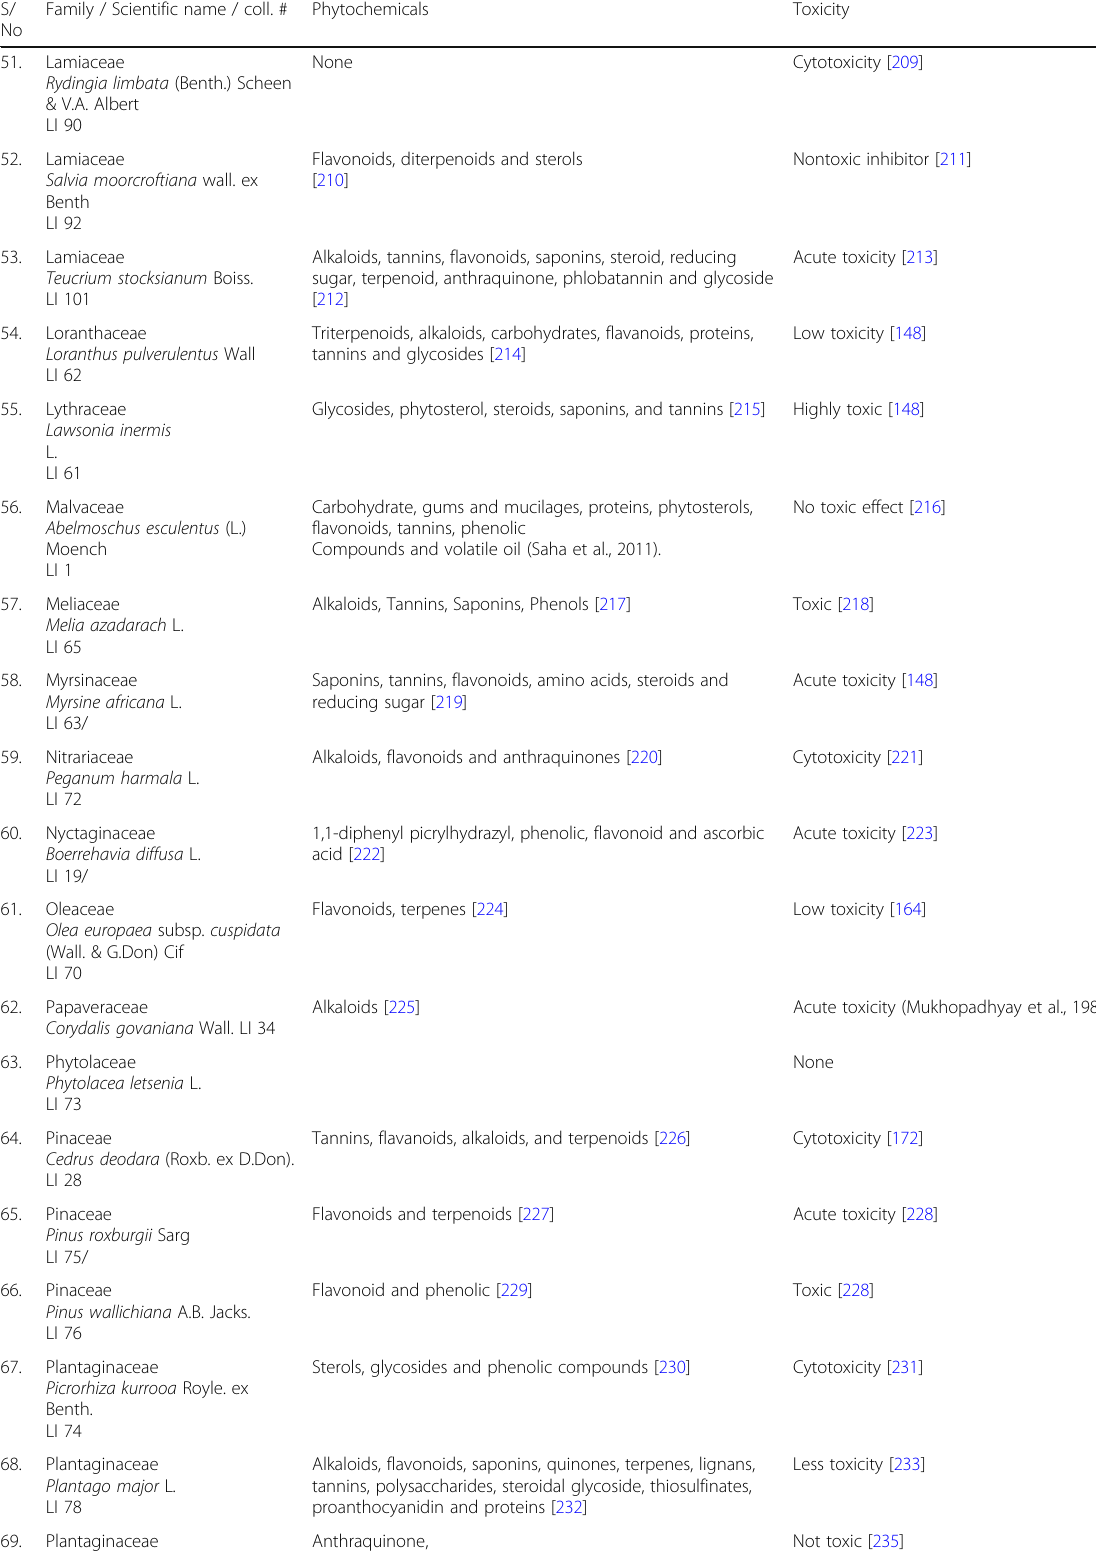
Table 5 Phytochemical activities and toxicity of medicinal plants used for skin diseases (Continued) S/ Family / Scientific name / coll. # No